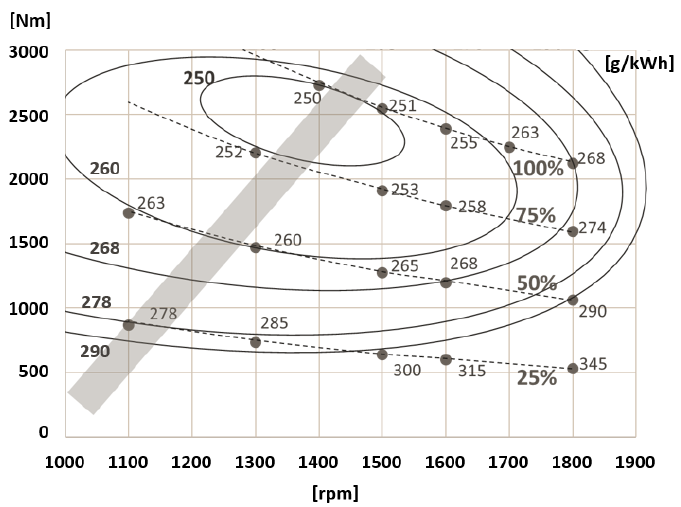
Figure 1. Generator–battery hybrid system using EMS.